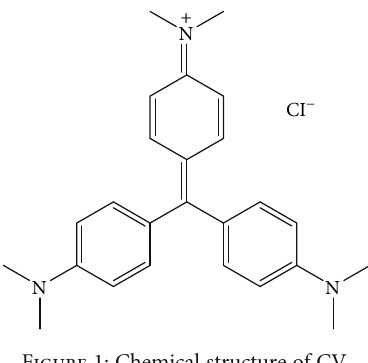
Figure 1: Chemical structure of